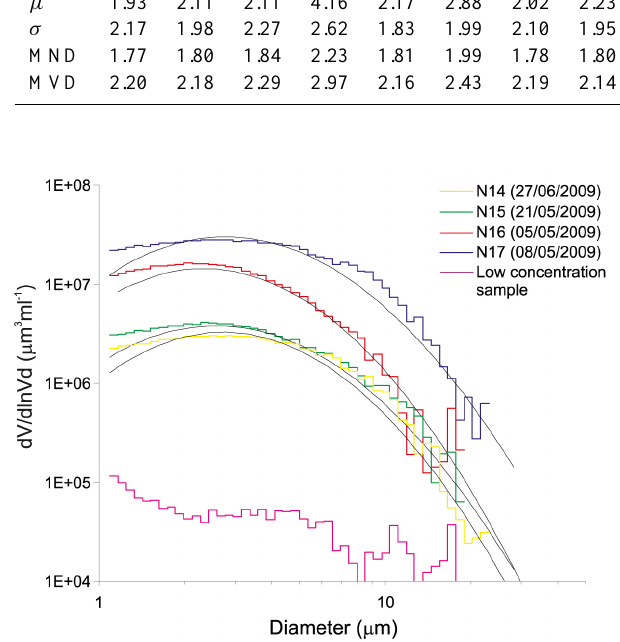
Fig. 8. Particle size distributions by volume with lognormal fits for the four dust deposition events recorded in 2009. Particle size dis- tribution for a sample which did not contain visible dust is shown for